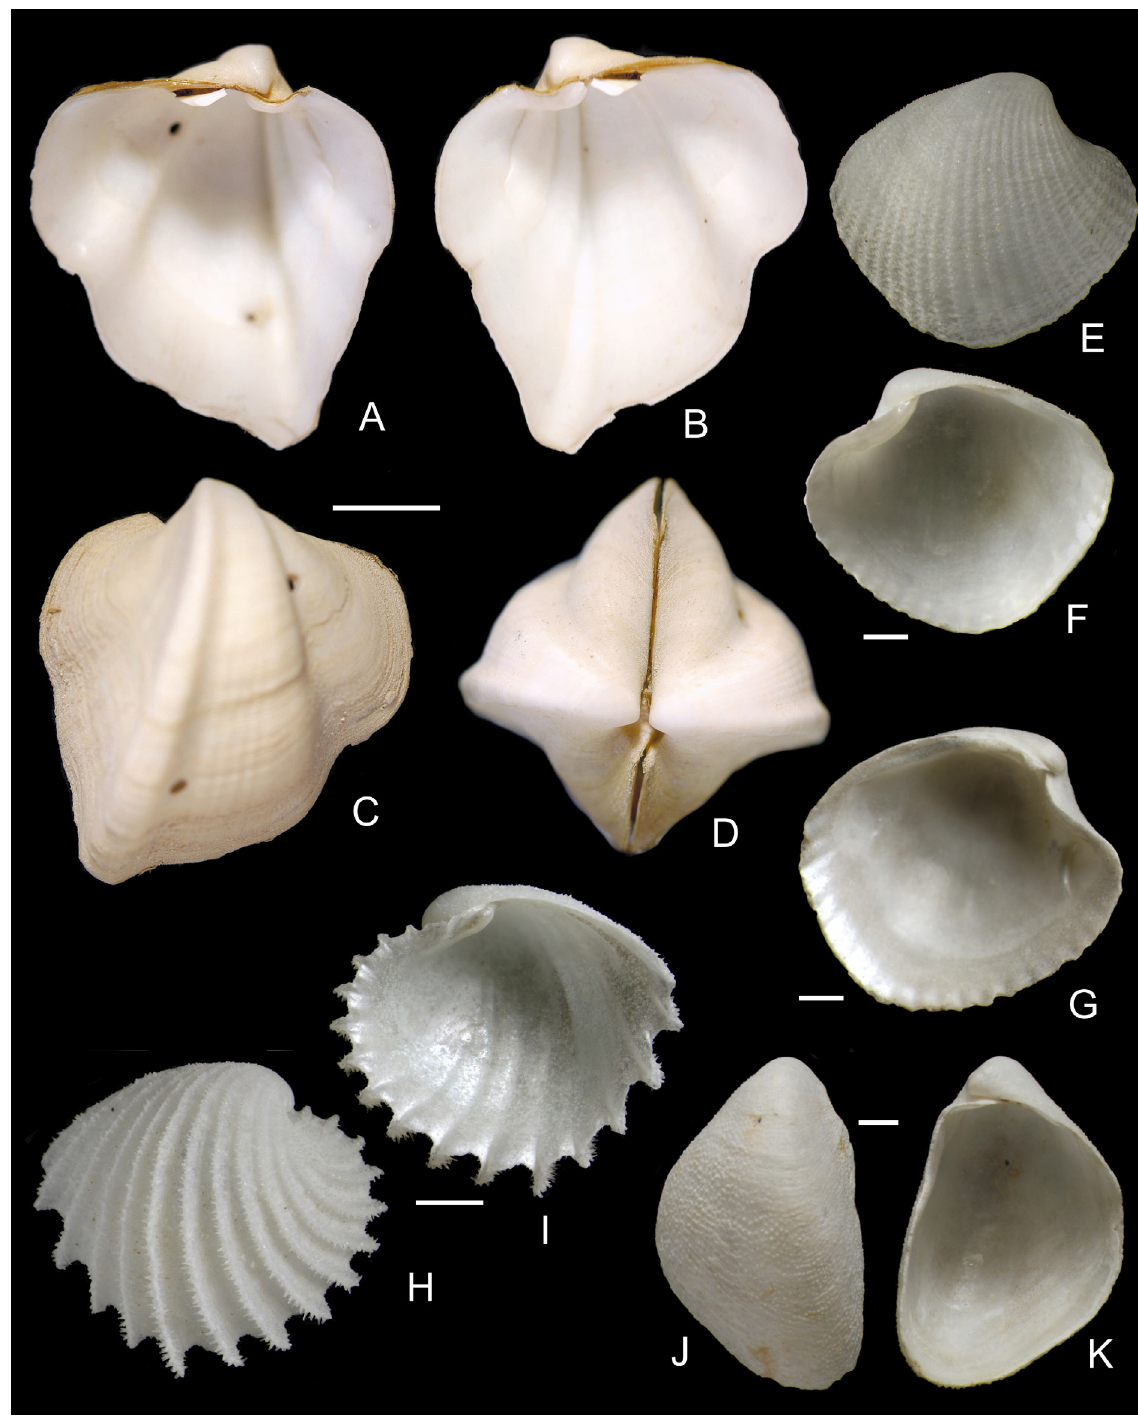
Fig. 40. Verticordiidae. A–D . Halicardia flexuosa Verrill & S. Smith, 1881, BANGAL 0711, V10, 1720 m, 38 mm. E–G . Haliris granulata (Seguenza, 1860), SEAMOUNT 1, DW106, 765 m, 6.9 and 7.3 mm. H–I. Spinosipella acuticostata (Philippi, 1844), BANGAL 0711, V3, 818 m, 5.0 mm. J–K . Halicardia angulata (Jeffreys, 1882), BANGAL 0711, V3, 818 m, height 8.6 mm. Scale bars: A–D = 10 mm; E–K = 1